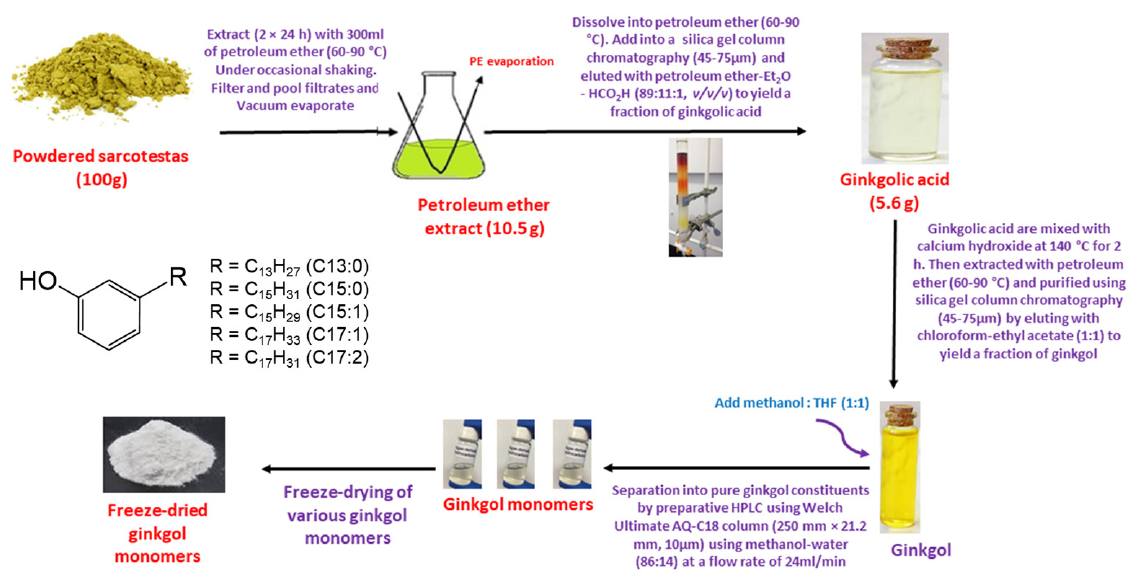
Figure 2. Schematic presentation of the ginkgols’ isolation.